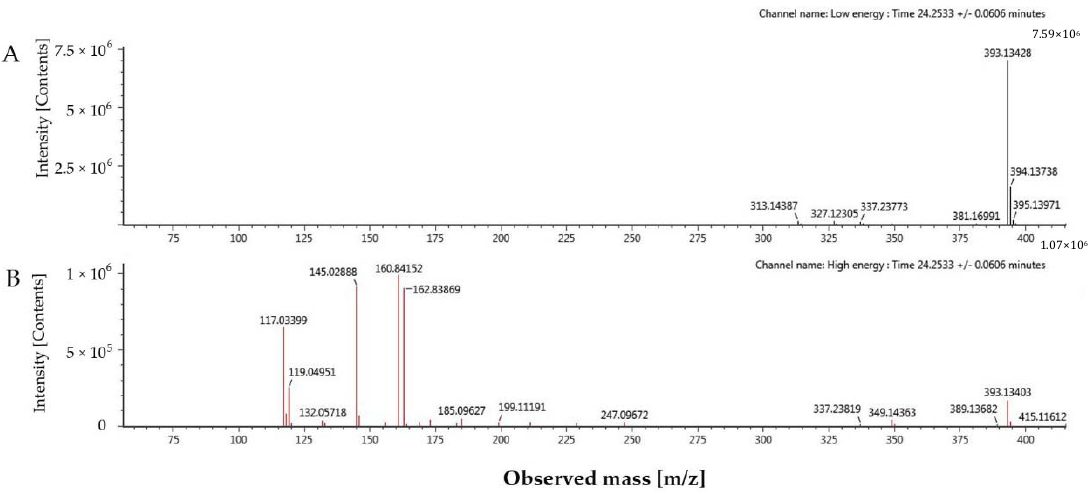
Figure 2. MS / MS spectra under low energy ( A ) and high energy ( B ) of 5-isoprenyl ca ff eic acid Figure 2. MS/MS spectra under low energy ( A ) and high energy ( B ) of 5 ‐ isoprenyl caffeic acid p ‐ p-coumaric acid coumaric acid ester.